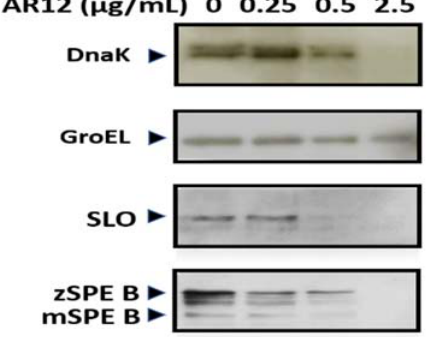
Figure 3. The expression of heat shock proteins and GAS exotoxins by AR-12 treatment. The NZ131 strain was incubated with different concentrations of AR-12 at 37 °C for 2 h, and total protein was isolated by bacterial total protein extraction kit. The protein samples were separated using SDS– PAGE and blotted with anti-DnaK or anti-GroEL antibodies and developed using an ECL Western blot detection kit. Furthermore, the mid-log and late-log phases of the GAS culture supernatants with or without AR-12 treatment were assessed by Western blotting using anti-SPE B and anti-SLO monoclonal antibody, as described in the Materials and Methods Section.